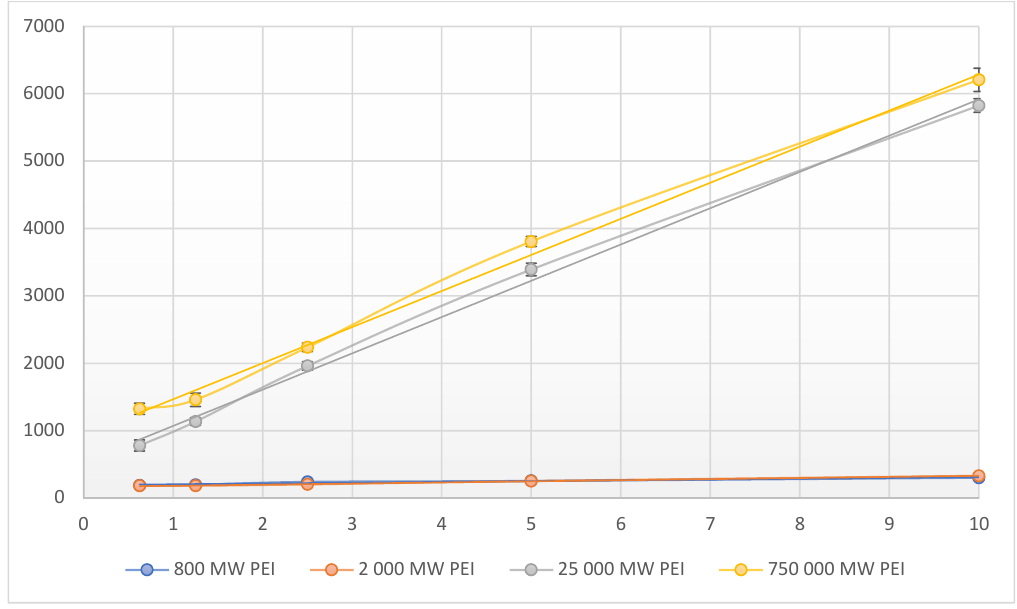
Figure 1. Fluorescent intensity related to mass concentration (0.625–1.25–2.5–5–10 mg/mL ( w/v )) of PEI with different molecular weights (0.8–2–25–750 kPEI) dilution series. Technical parameters: λ ex = 280 nm; λ em = 290–720 nm; scan speed = 1200 nm/min; PMT voltage = 700 V. Maximal emission: λ em = 560nm; pH ≈ 10.6. The standard 3.5 mL quartz cuvette were OD: 12.5 mm × 12.5 mm × 45 mm; wall thickness: 1.25 mm with 10 mm light path and four polished sides. The volume of all the samples was 1 mL. Technical parameters of the assay—sample number: 5/measuring point; temperature: 23 °C.